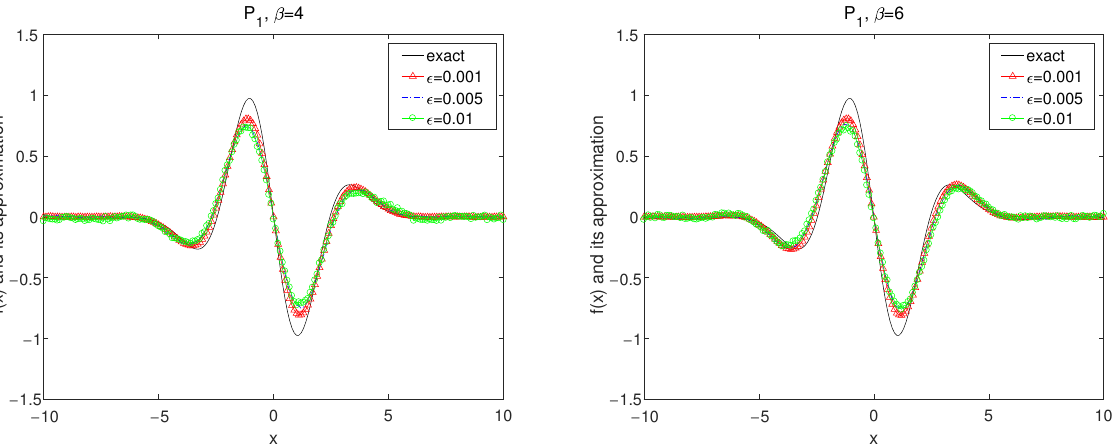
Figure 3. The exact solution and the regularized solutions with β = 4,6 using kernel P 3 under the a priori choice rule for Example 1.